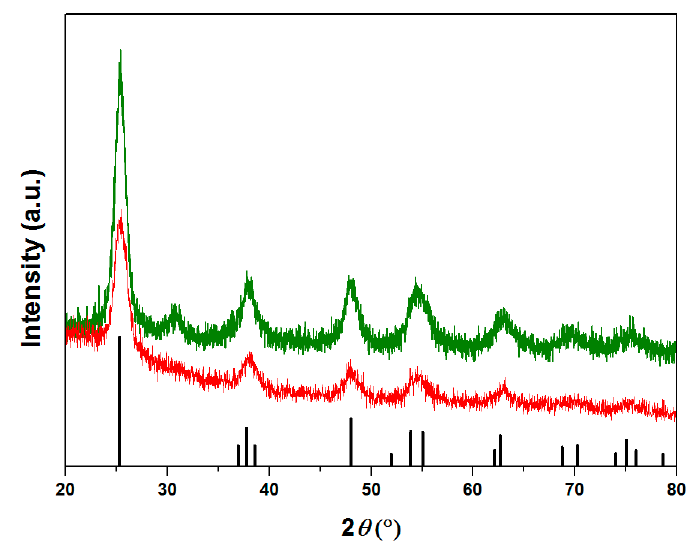
Figure 1. XRD patterns of Samples A (green curve), sample B (red curve), and crystallographic peaks of anatase phase (black line pattern). (Color figure online).